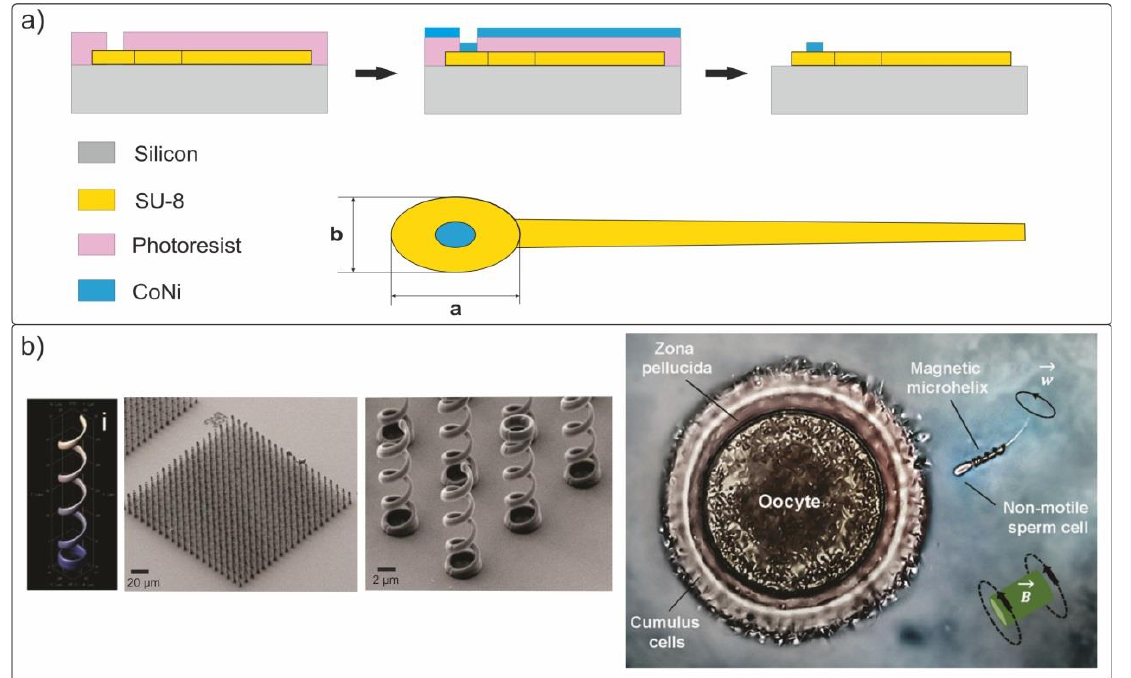
Figure 10. ( a ) Schematic structure of a biomimetic spermatozoon of 322-µm length. The dimensions of the ellipsoidal head are a ≈ 42 µm and b ≈ 28 µm. ( b ) SEM photos of four-turn microhelices and the process of transporting a sperm cell captured by a magnetic microhelices [138]. Copyright 2016, American Chemical Society.